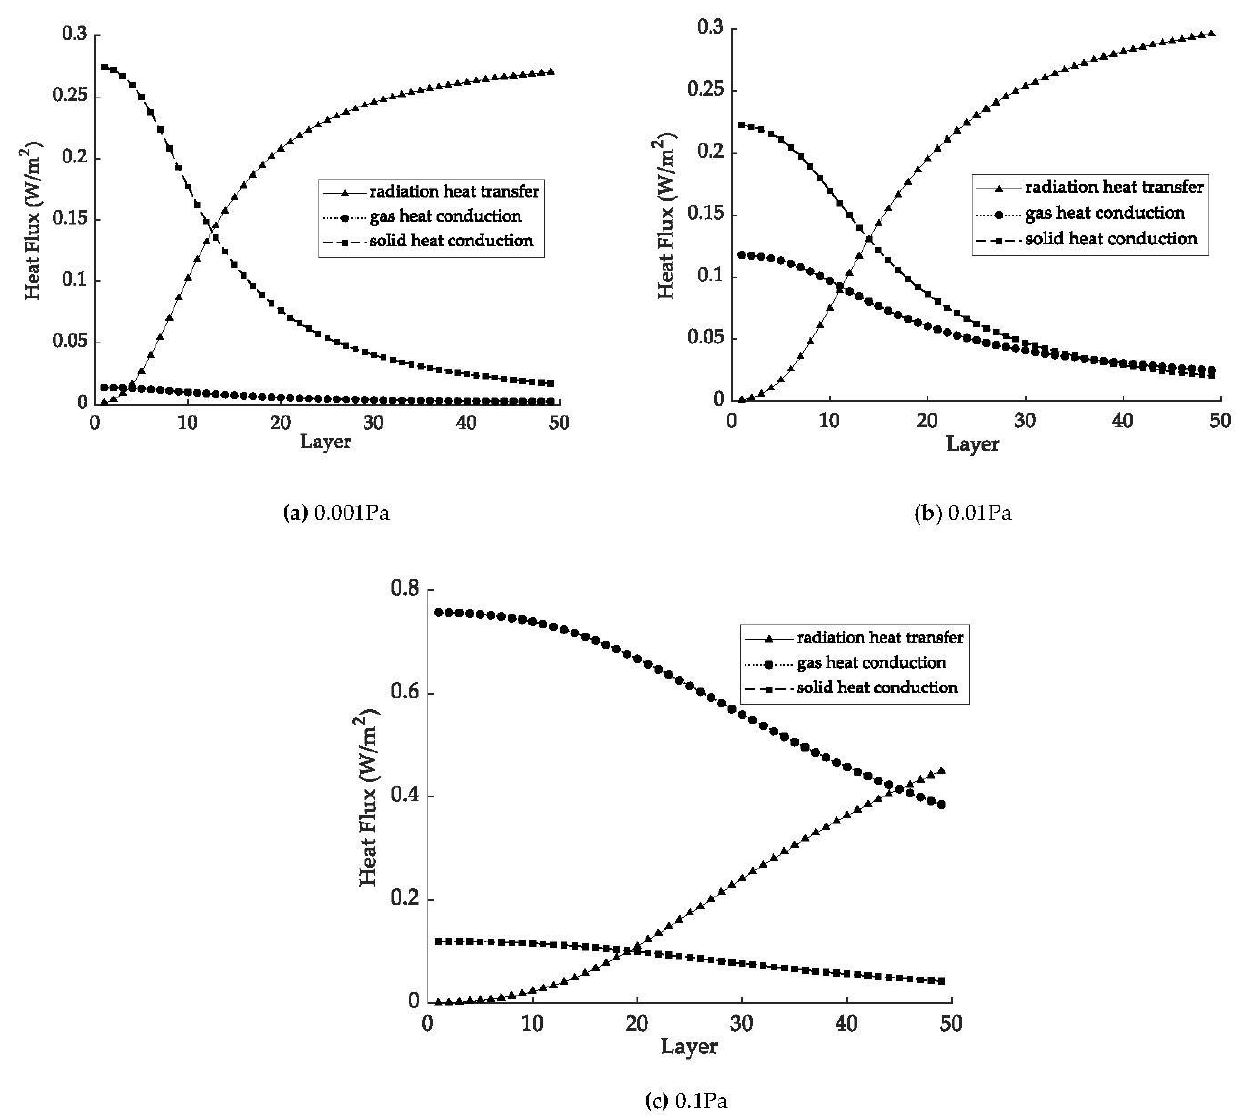
Figure 8. Variation in heat flux with the layer position.